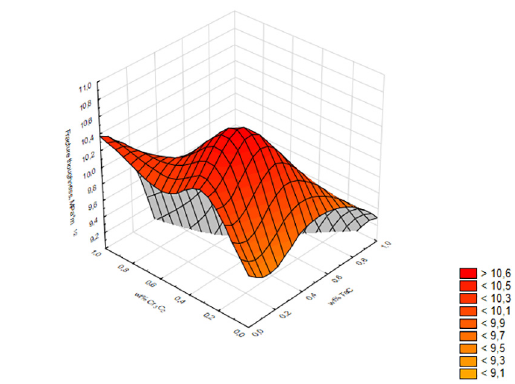
Figure 6. Fracture toughness as function of additive contents of spark plasma sintered WC-6 Co cemented carbides. Corresponding assay data are presented in Table